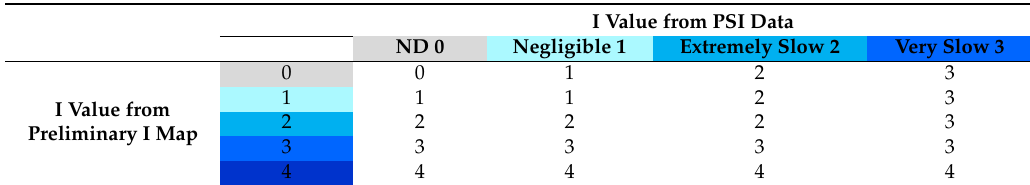
Table 3. Contingency matrix (MATRIX 1), which combines I values from PSI V SLOPE-ABS and from the Preliminary I map for deriving five final Intensity classes I f .